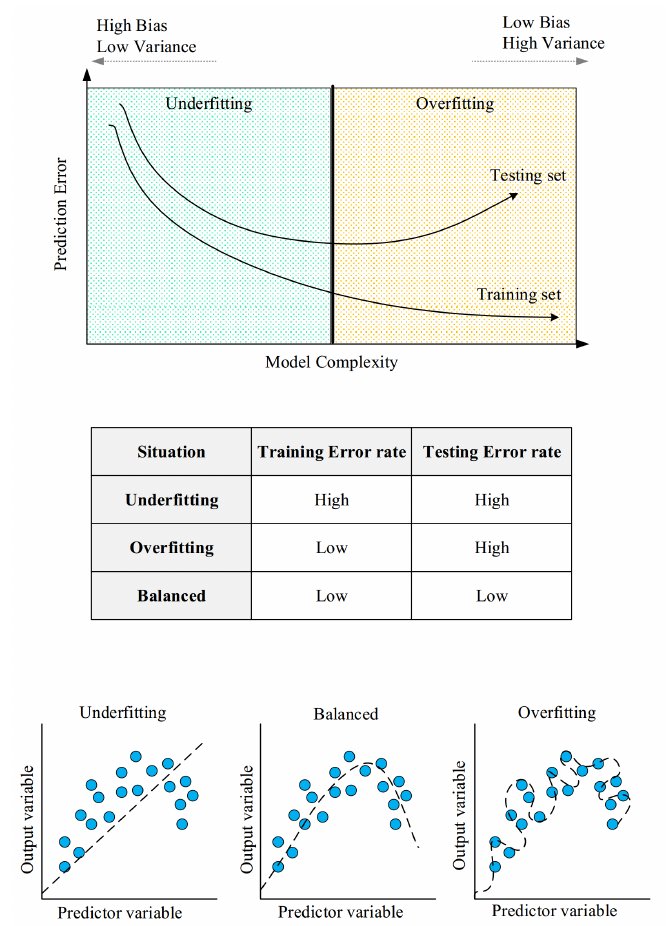
Figure 4. Overfitting or underfitting